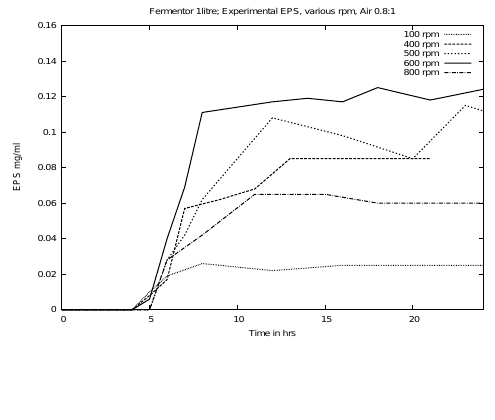
Fig. 2. Experimental EPS for different rpm